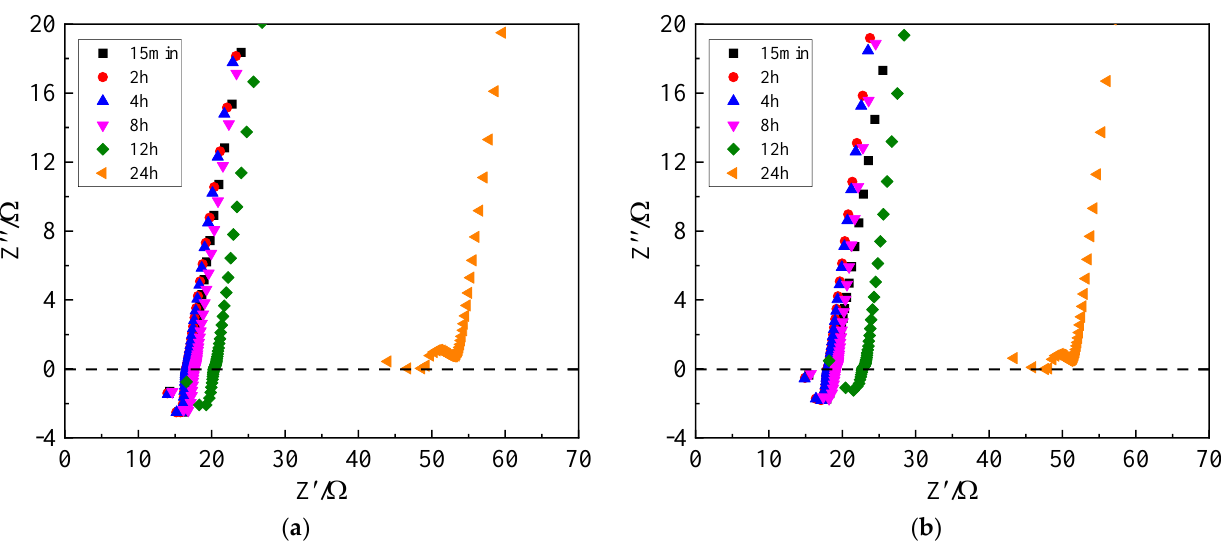
Figure 5. The Nyquist plots of cement paste with superplasticizer. ( a ) SP − NP0; ( b ) SP − NP1. Compared with SP − NP0, the pore solution resistance of SP − NP1 cement paste in- creased. When the cement paste hydrated for 15 min, 2 h, 4 h, 8 h, and 12 h, the pore solution resistances of SP − NP1 were 18.9 Ω, 17.9 Ω, 18.0 Ω, 19.2 Ω, and 22.8 Ω, respec- tively. Wang et al. [43] believed that nanoclay particles adsorb more strongly on the su-